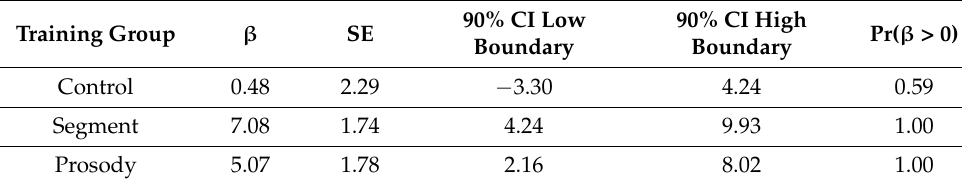
Table 13. Statistical results for